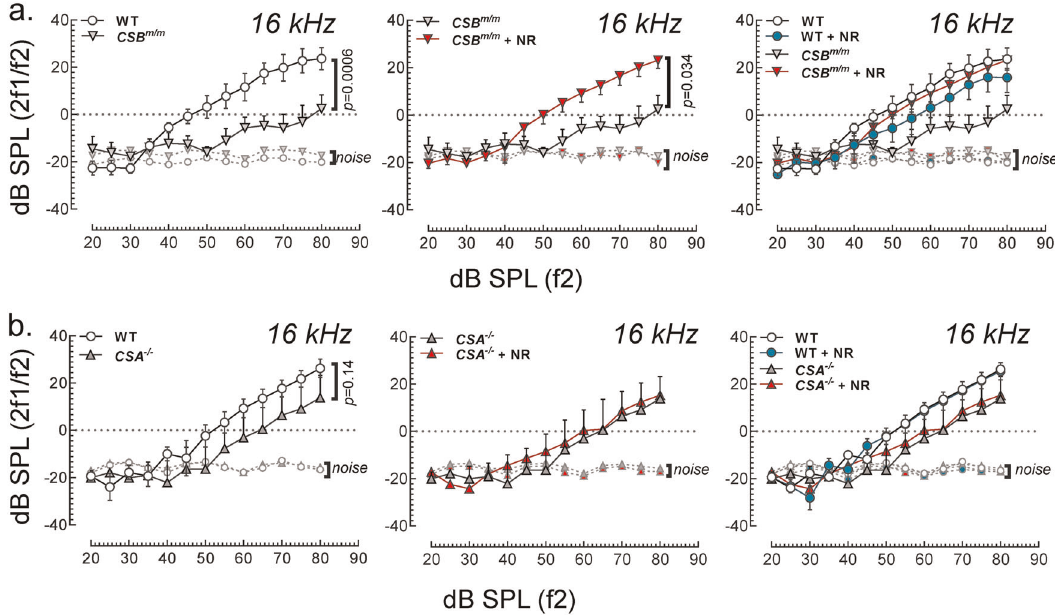
Fig. 3 Short-term NR supplementation restores reduced DPOAE levels in CSB m/m mice at 16 kHz. a NR intervention (12 mM of NR for 7 weeks) corrects reduced DPOAEs in CSB m/m mice at 12 weeks of age at 16 kHz ( CSB m/m ( N = 5); CSB m/m + NR ( N = 3); WT ( N = 7); WT + NR ( N = 6)). Multiple graphs are used to visualize error bars in each dataset. b DPOAE levels in CSA − / − and WT at 9 weeks of age ( CSA − / − ( N = 6); CSA − / − + NR ( N = 5); WT ( N = 3); WT + NR ( N = 4)) were recorded at 16 kHz following 4 weeks of NR treatment (24 mM) in their drinking water. Mean ± S.E. is shown in all graphs. Multiple graphs are used to visualize error bars on each dataset. The input in dB/output in dB functions in the range from 50 dB SPL to 60 dB SPL input were used to perform statistical analysis on groups, followed by a linear mixed-effect model on repeated-measures of DPOAEs in each group.